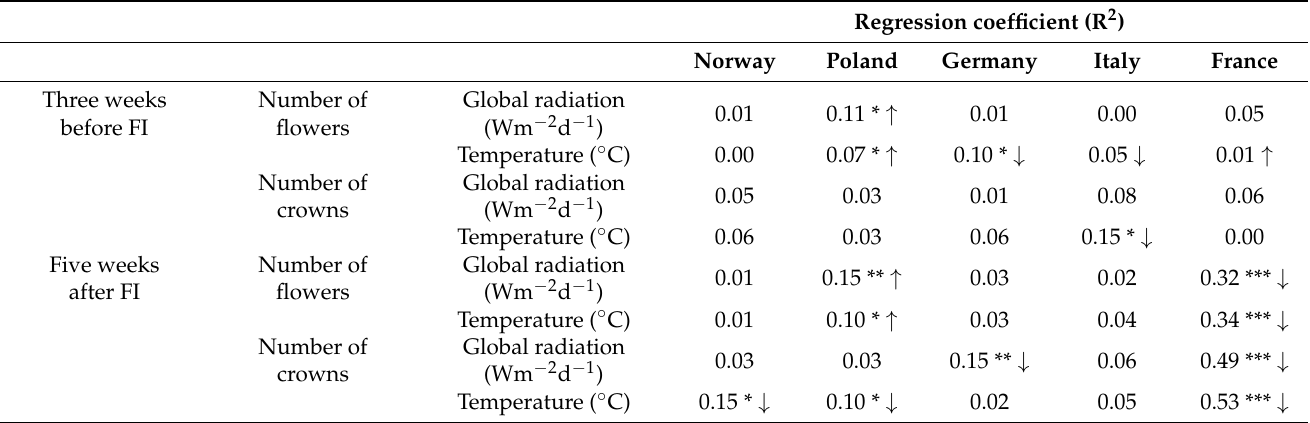
Table 4. Regression coefficient (R 2 ) for the number of flowers and crowns as an average of six strawberry cultivars related to global radiation and temperature during the 3-week period preceding and 5 weeks after flower initiation (FI) when grown at five locations in Europe.